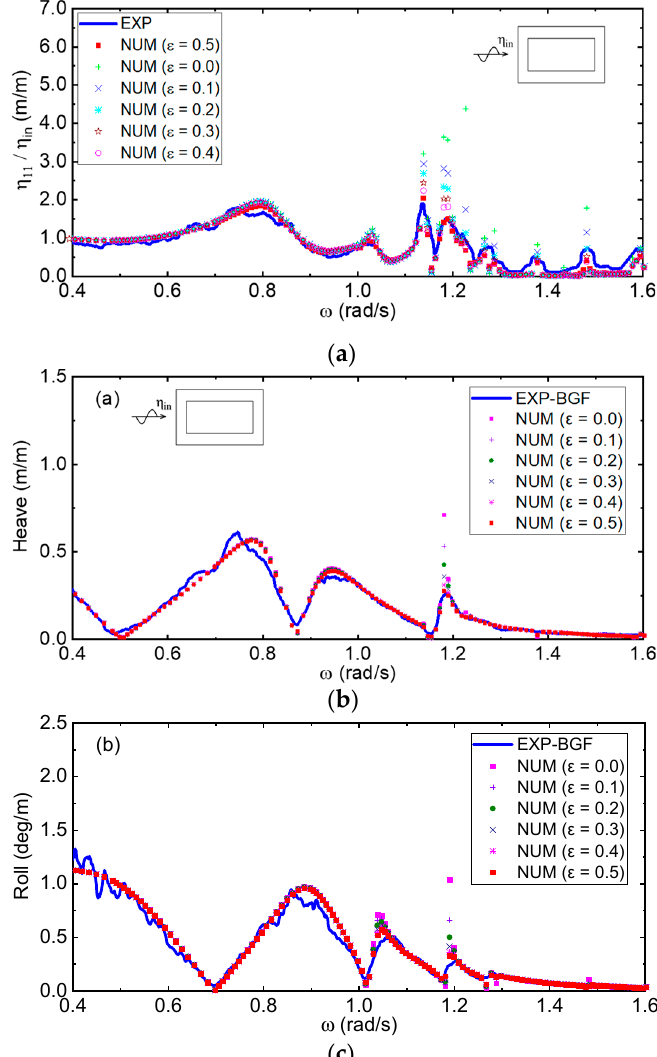
Figure 6. ( a ) RAOs of free surface elevations at the center of the sheltered water (RW11); ( b ) heave RAOs of the floating barge frame; and ( c ) roll RAOs of the floating barge frame in 90 deg incident wave direction [22].